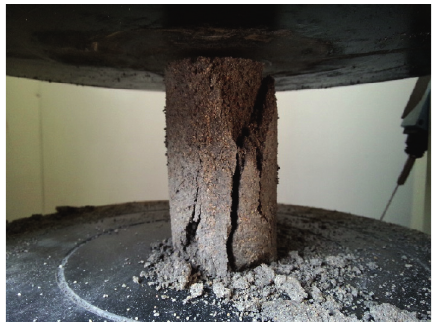
Figure 4: Uniaxial compression